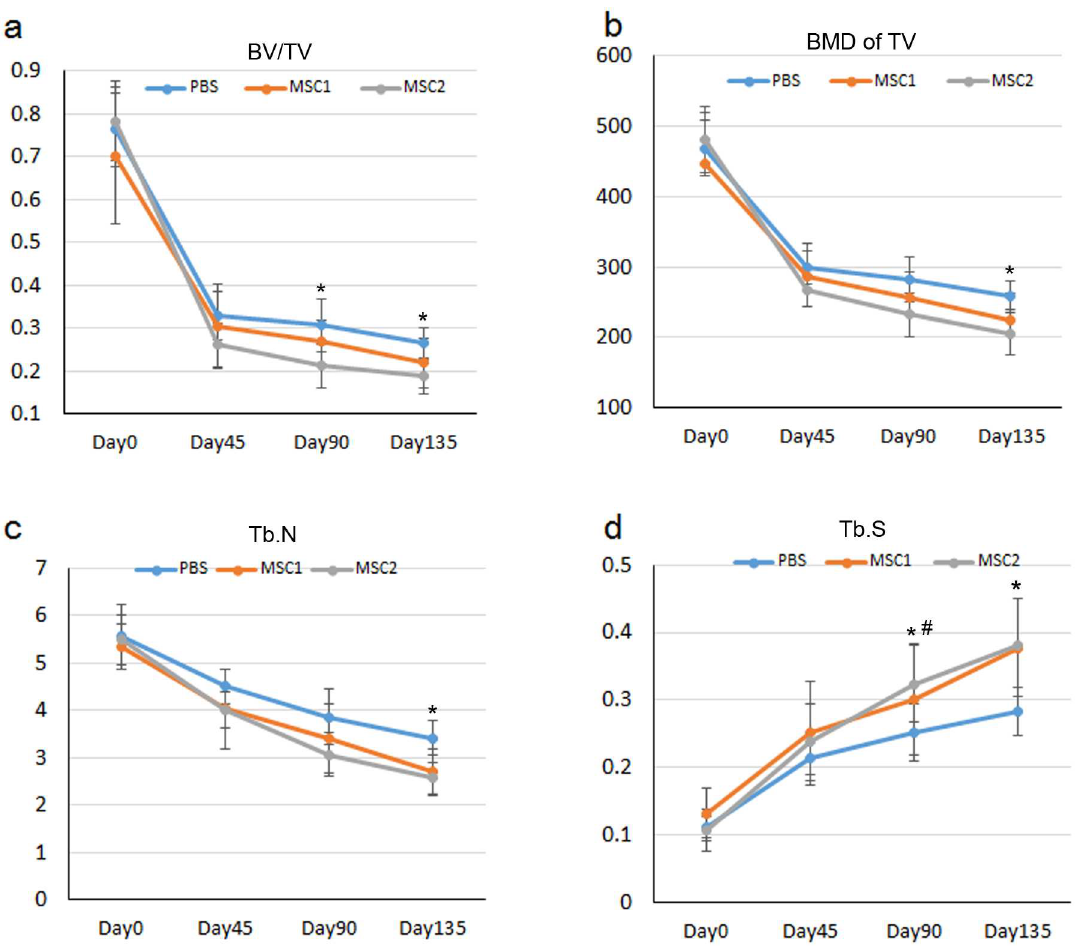
Fig 3. Micro-CT analysis of the trabecular bone. At Day 0, 45, 90, 135 followingOVX, the trabecular bones were analyzedby Micro-CT. (a) BV/TV, (b) BMD of TV, (c) trabecularnumber and (d) Trabecular spacing were analyzed.Data was presented as mean ± SD (n = 8). Significant level was taken at p < 0.05. * p < 0.05, MSC2 compared with PBS group. #p < 0.05, MSC2 compared with MSC1 group.